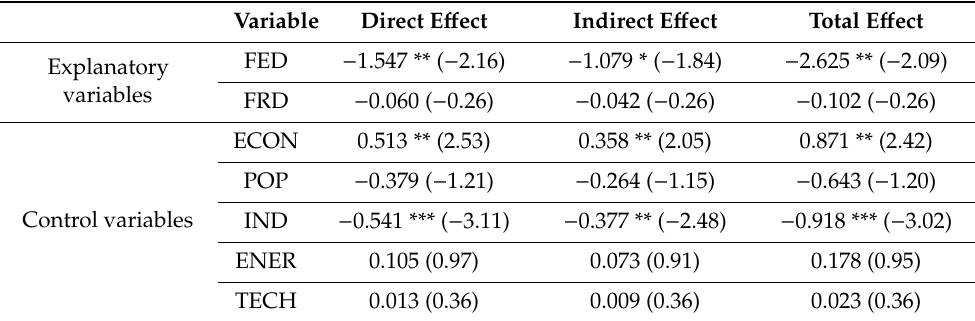
Table 6. Direct e ff ect, indirect e ff ect and total e ff ect of fiscal decentralization on EFPE in China